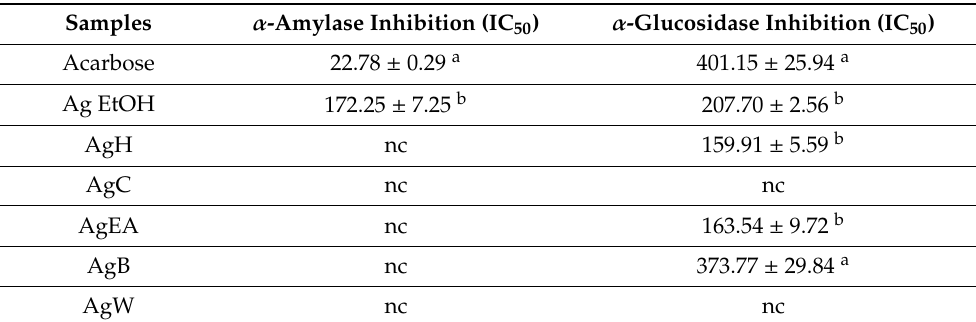
Table 4. α -Amylase and α -glucosidase inhibition by acarbose and Azorella glabra samples expressed as IC 50 values in µ g /